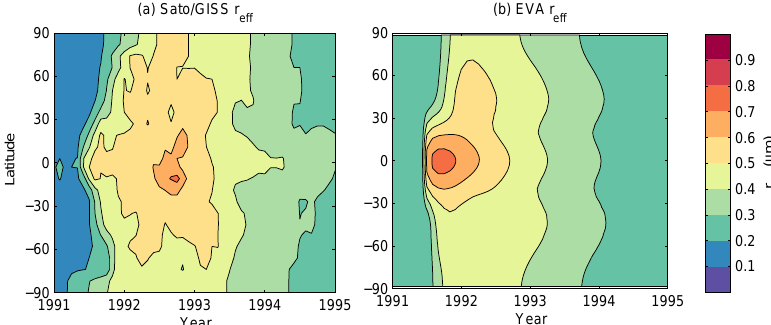
Figure 6. Zonal mean effective radius after Pinatubo from the (a) Sato/GISS reconstruction and (b) EVA.